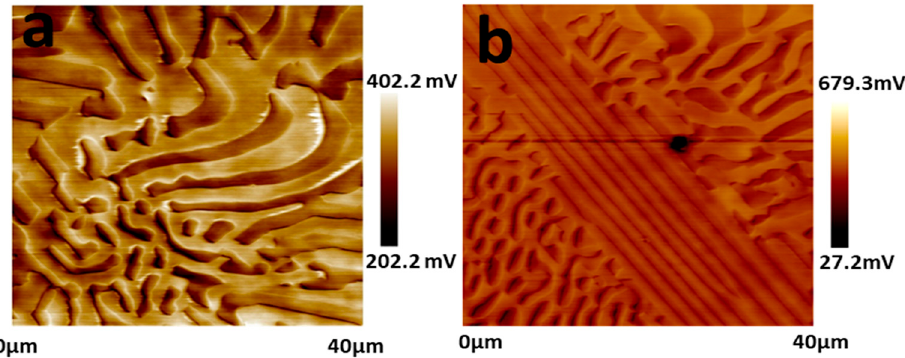
Figure 4. Volta potential mappings of AlCoCrFeNi 2.1 tested by SKPFM. ( a , b ) potential map of the irregular region and the lamella region.